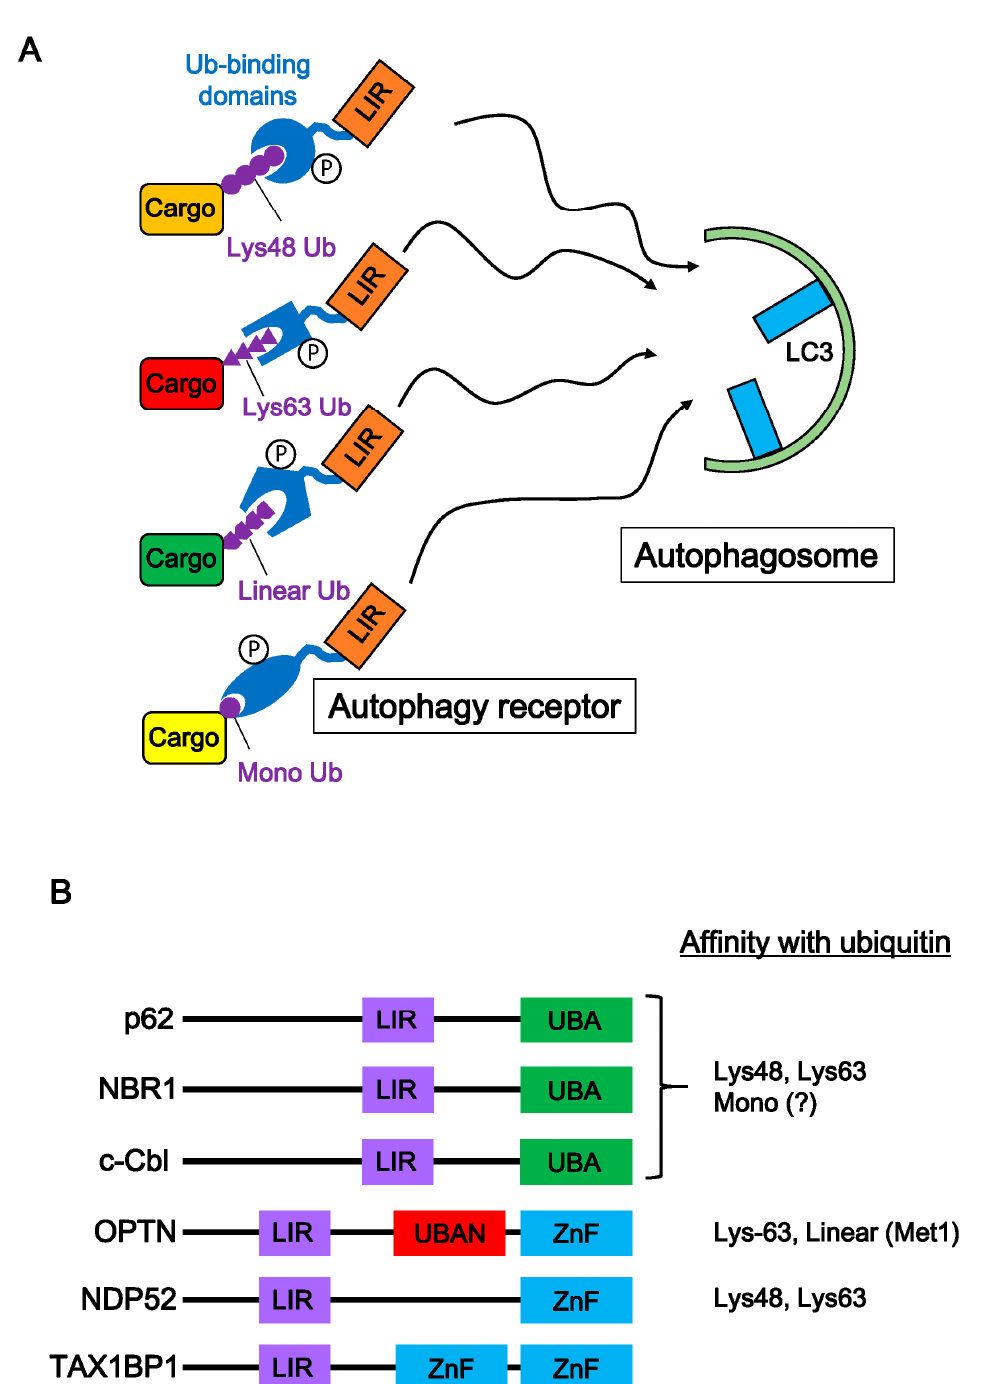
Figure 3. Autophagy receptors and selective autophagy of ubiquitinated cargoes. ( A ) Autophagy receptors play an important role in selective autophagy. Appropriate autophagy receptors bind to various ubiquitinated cargoes (Lys-48-, Lys-63-, linear-poly-ubiquitin chain, and mono-ubiquitin) through their ubiquitin binding domain. Many autophagy receptors are regulated by various kinases, and then autophagy receptor-cargo complexes interact with the autophagosome protein, LC3. ( B ) Structure of major autophagy receptors. Autophagy receptors consist of an LIR domain and a ubiquitin binding domain. Ubiquitin binding domains (UBA, UBAN, and ZnF) are classified based on motif sequences. Biochemical studies show preferences of autophagy receptors for ubiquitin types. Activation of autophagy receptors is mediated by various kinases. For example, p62 is phosphorylated by various kinases, such as mTORC1, casein kinase 1, and TBK1 [64,115,116]. OPTN